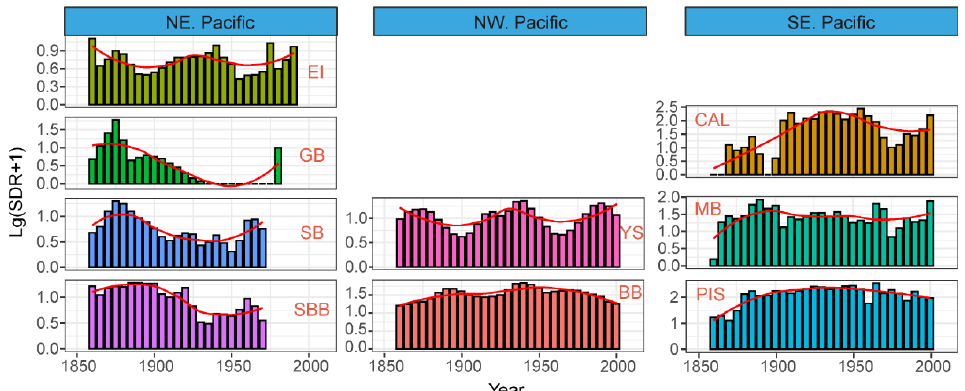
Figure 2. Long-term changes in the SDR from sites in the Pan-Pacific. SDR: scale deposition rate (#scales cm − 2 yr − 1 ). Red lines represent the smooth curve with a loess method. YS: Yellow Sea; BB: Beppu Bay; EI: Effingham Inlet; SBB: Santa Barbara Basin; GB: Guaymas Basin; SB: Soledad Basin; CAL: Callao; PIS: Pisco; MB: Mejillones Bay.